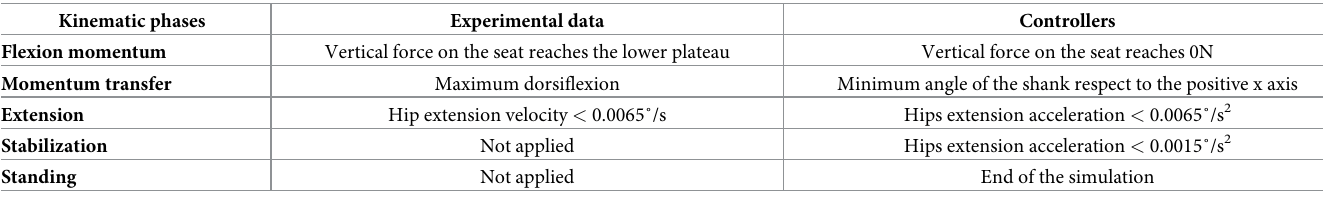
Table 5. Comparison between algorithms for detection of kinematic